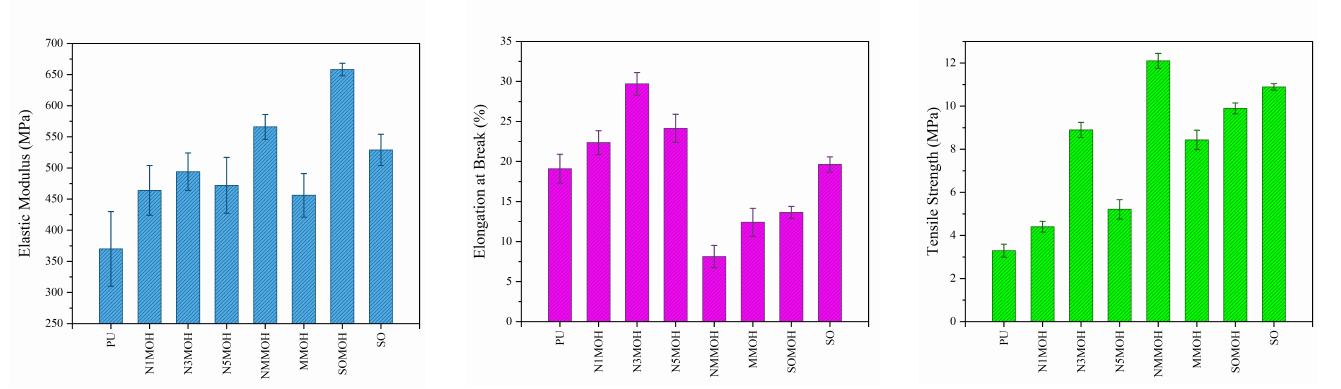
Figure 11. Tensile strength, elongation at break, and elastic modulus variations of the nano-, micro-, and hybrid PU composite